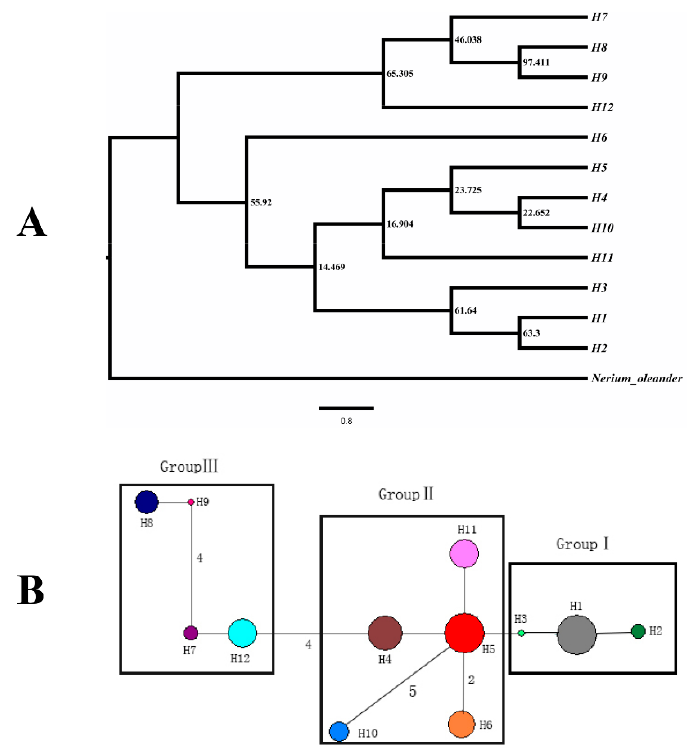
Figure 3. Bayesian tree ( A ) and the network of haplotypes ( B ) based on combined cpDNA sequences. ( A ) The numbers on branches indicate the posterior probability; ( B ) the size of the circles corresponds to the frequency of each haplotype, and the vertical branches indicate mutational steps.